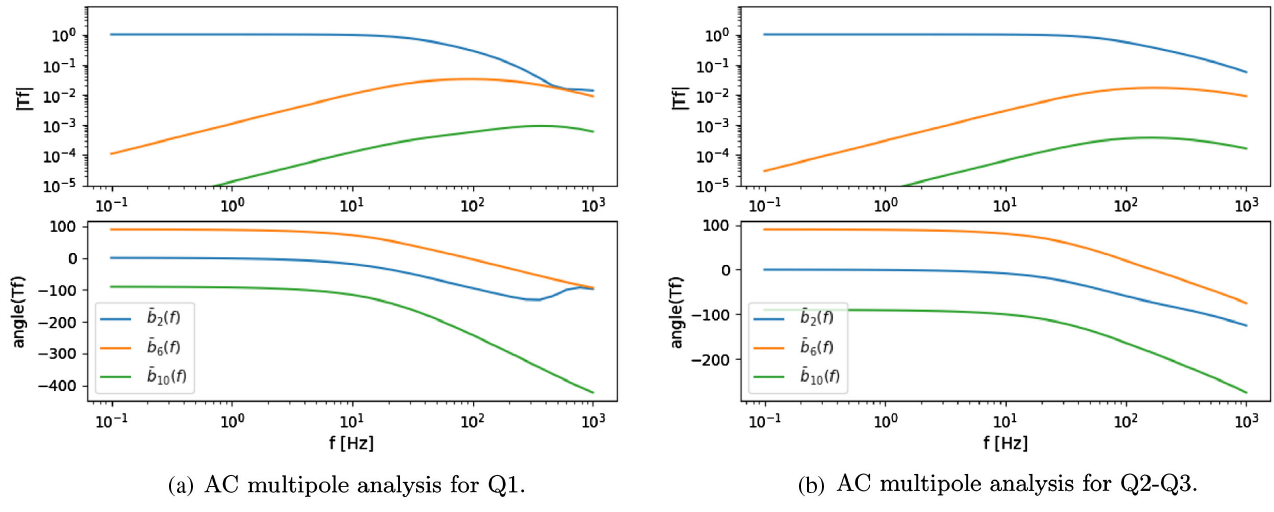
FIG. 10. AC multipole analysis for the beam screens of the HL-LHC triplet quadrupoles at 80 K.